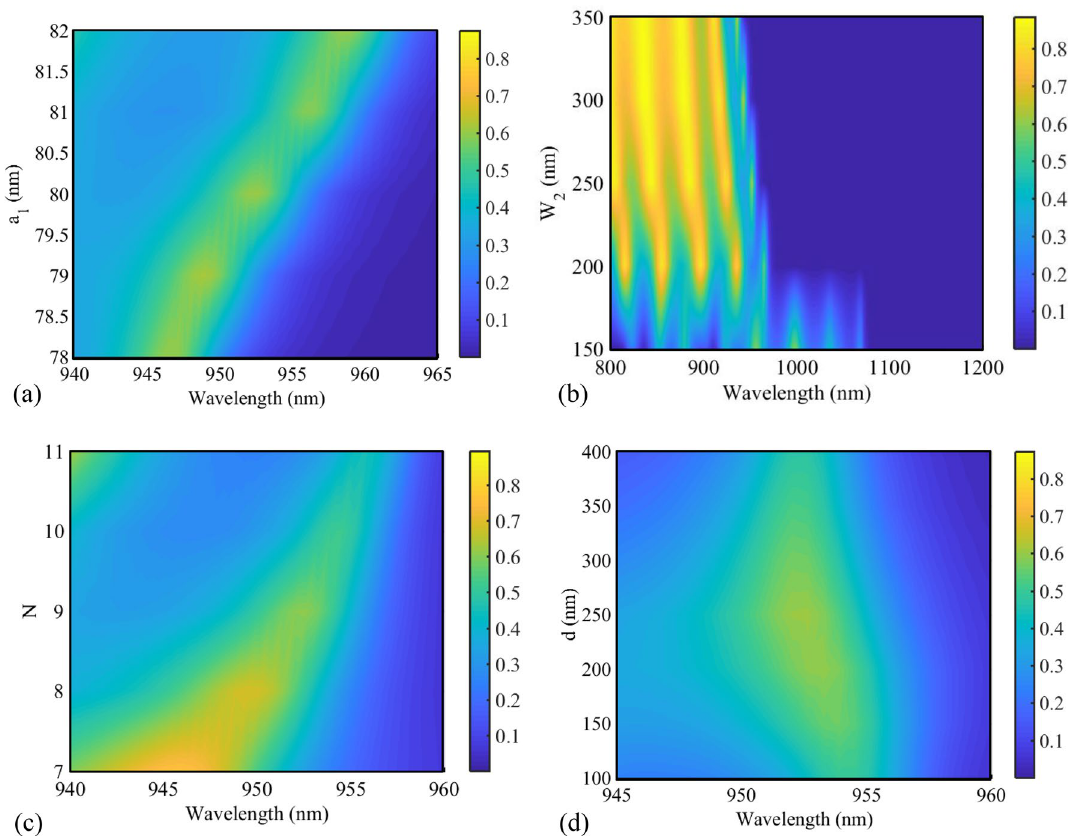
Figure 15. Transmission spectra of the proposed biosensor II for different values of ( a ) a 1 , ( b ) W 2 , ( c ) N, and ( d )